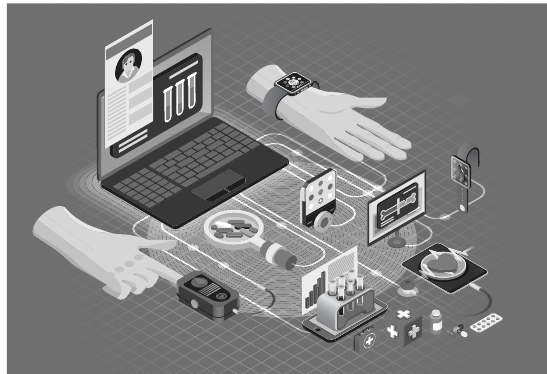
Figure 7. Real-time continuous